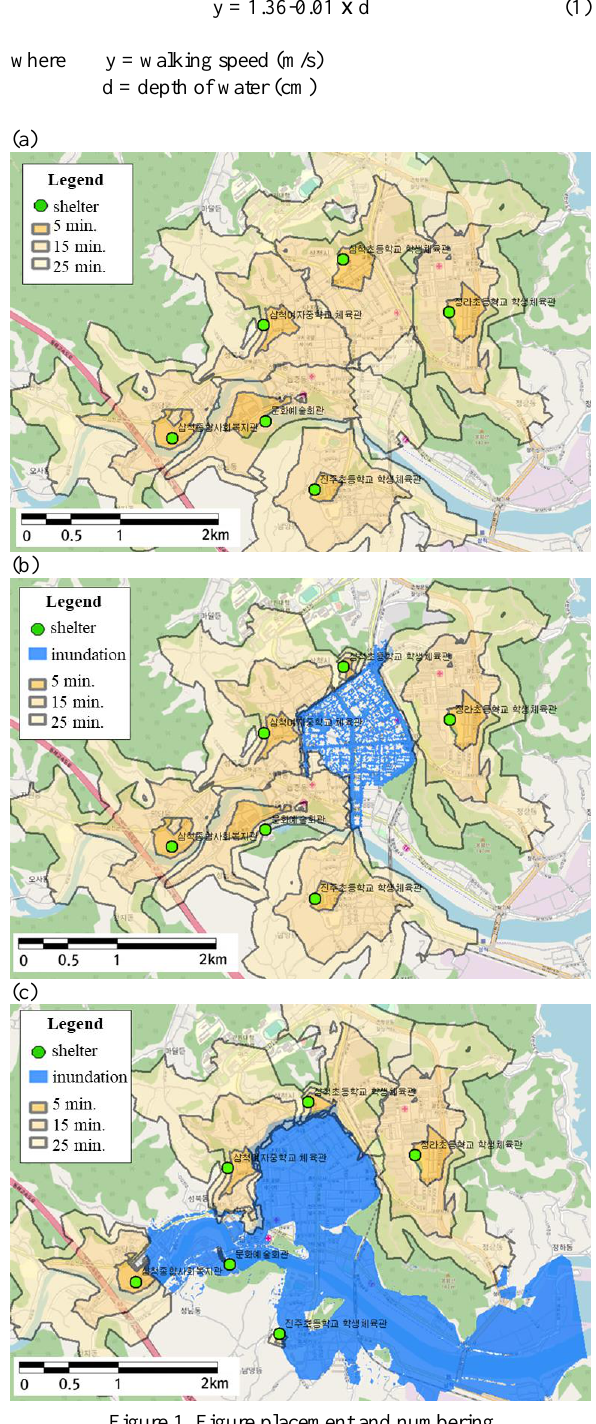
Figure 1. Figure placement and